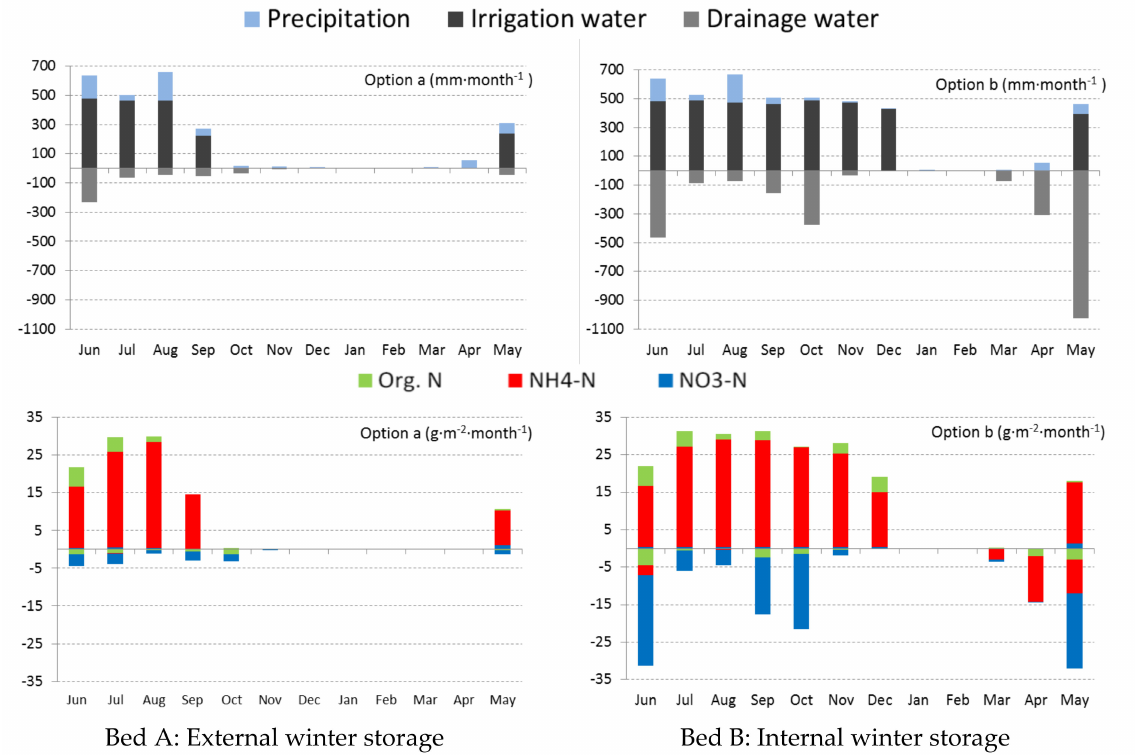
Figure 6. Monthly water and nitrogen balance investigated within the second year. The TN composition is presented in terms of Org. N, NH 4 + -N and NO 3 − -N (Note: The positive values denote the irrigation water and applied nitrogen and the negative values denote the drainage water and the leached